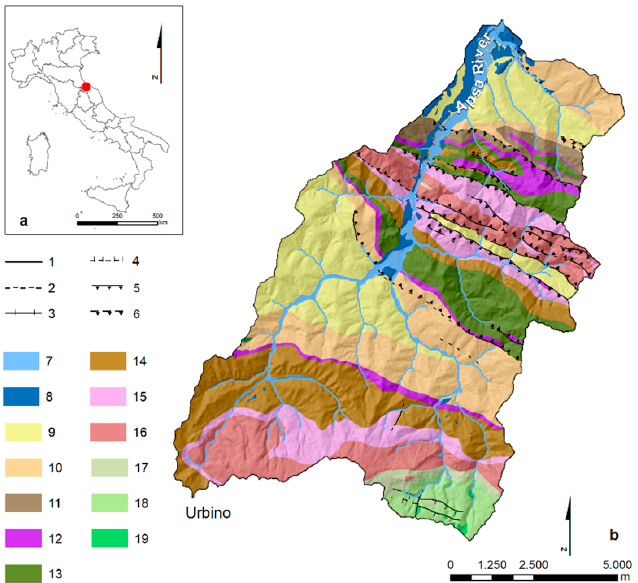
Figure 6. Location of the study area in the Northern Apennines of Italy and geological map. ( a )